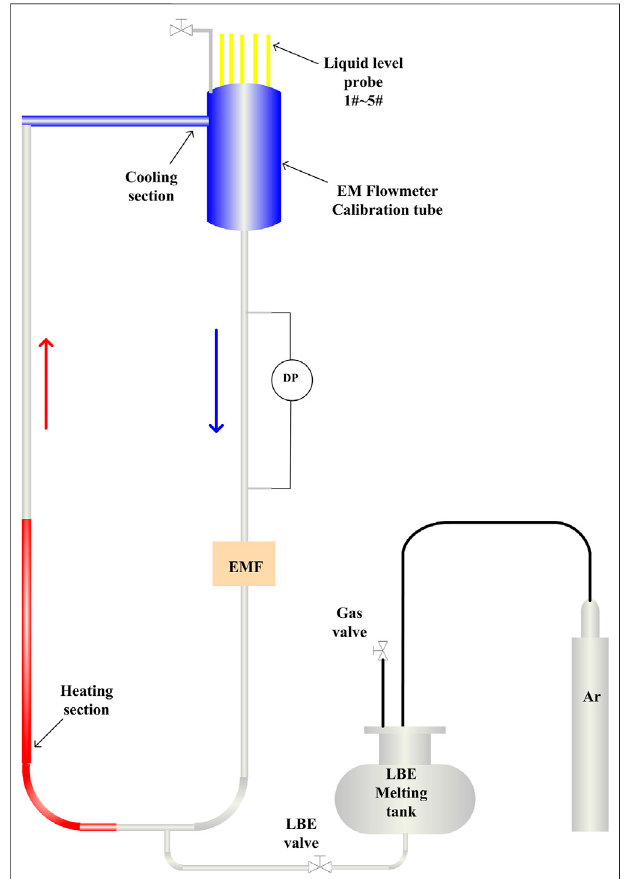
FIGURE 7 | Schematic of the NCCL test facility (Shi et al.,